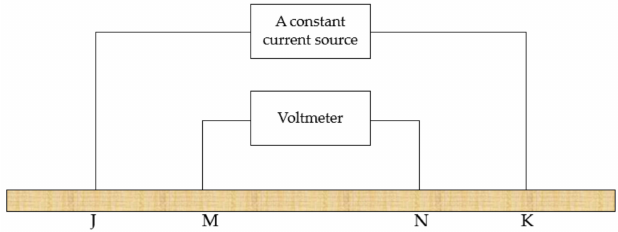
Figure 2. Schematic diagram of current-voltage four-terminal